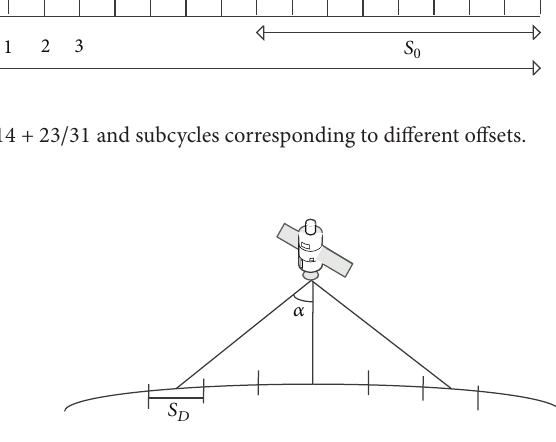
Figure 3: Observe the ground target by a sensor with a wide swath width.